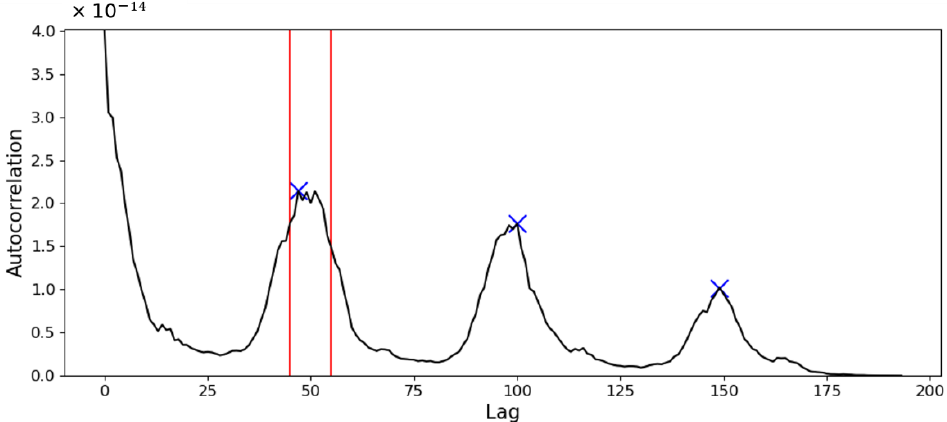
Figure 7. Autocorrelation from frequency signal with marked peaks and tested